Question: Author a descriptive caption for the visualization shown.
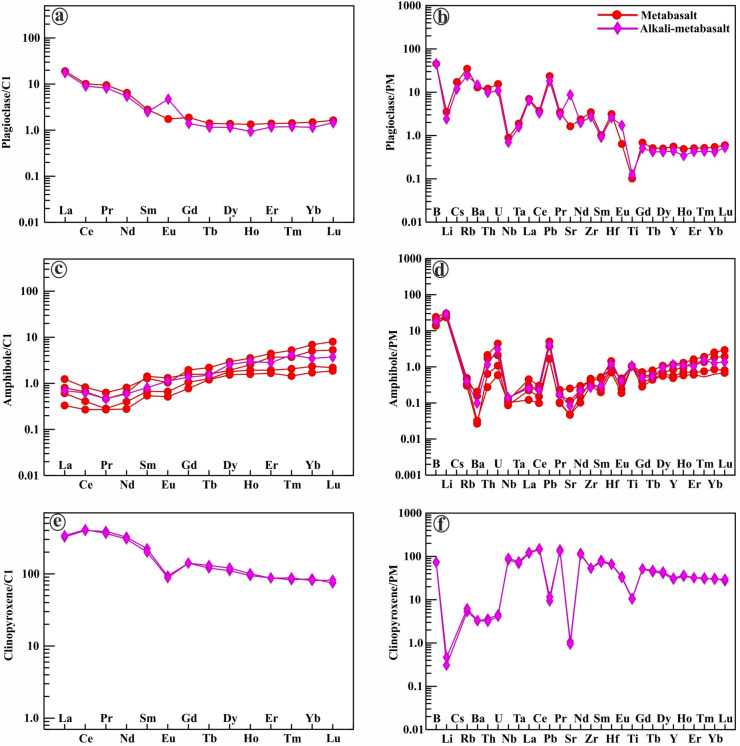
Answer: Chondrite (C1)-normalized REEs patterns and primitive mantle (PM)-normalized trace-element patterns of plagioclase ( a ), ( b ), amphiboles ( c ), ( d ), and clinopyroxene ( e ), ( f ). Normalized C1 and PM values are according to McDonough and Sun 80 . This figure is created by the Igpet 2010 software ( https://www.rockware.com/product/igpet/ ).